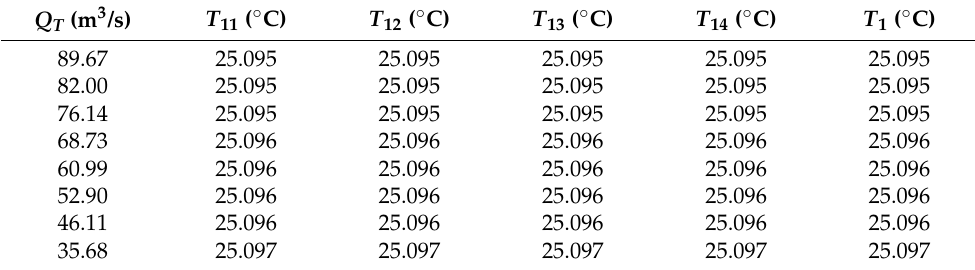
Table 5. Manifold ´ s temperature, high-pressure section.